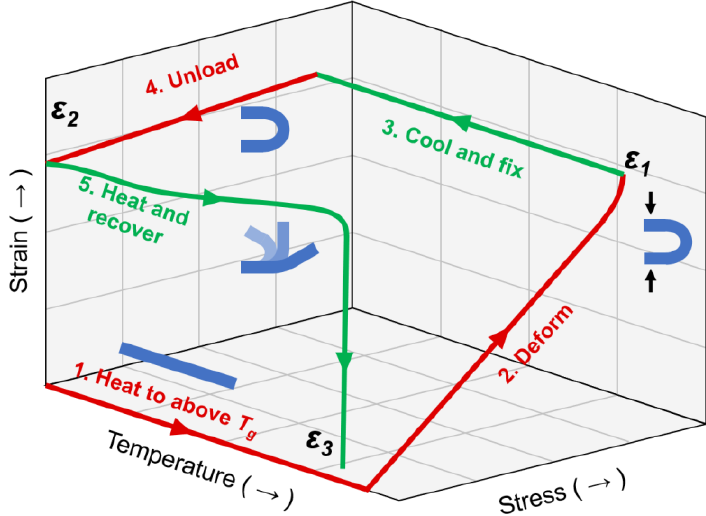
Figure 12. Shape memory behaviour and thermomechanical cycle.